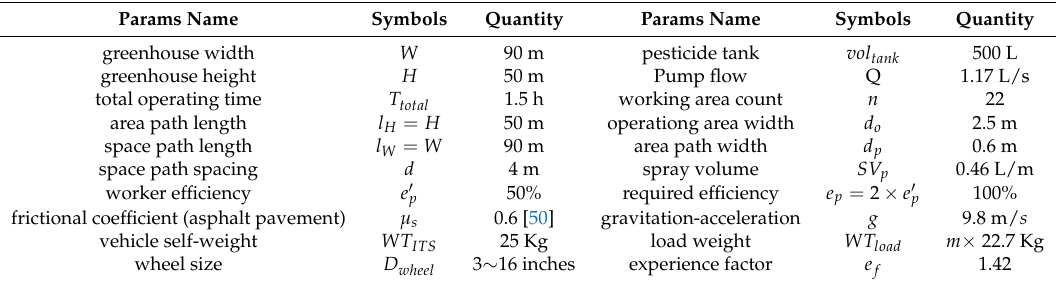
Table 2. Instance of parameters in a greenhouse